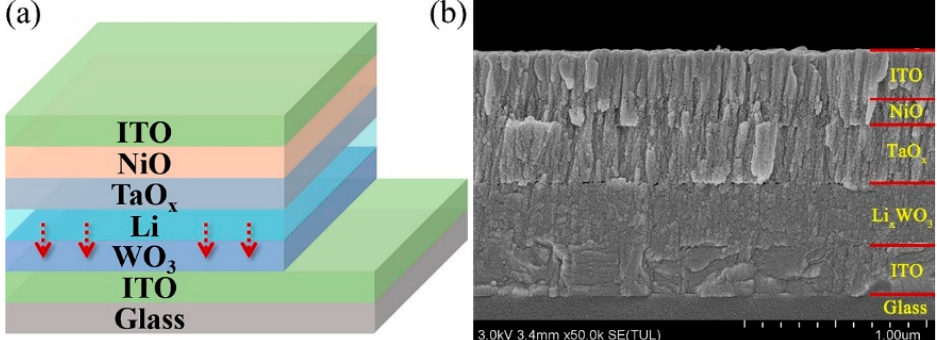
Figure 9. Structural schematic diagram ( a ) and cross-sectional morphology ( b ) of the all-solid-state ECD. (Arrow represents Li diffusion into WO 3 layer)